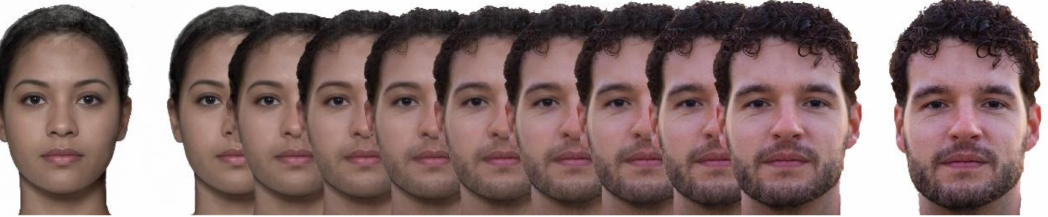
Figure 2. On the left, an average female template (DeBruine, Lisa & Jones, Benedict (2017), obtained using the app at http://faceresearch.org/demos/average (accessed on 1 January 2020), and shared with a CC-BY-4.0 license. On the right, a picture of a male model (not participant), sourced under a free license from unsplash.com. Between the faces, 9 equally spaced morphing steps, obtained using Webmorph (see article text). The image is created to illustrate the experimental procedure and does not include stimuli used in this study, to respect participants’ privacy